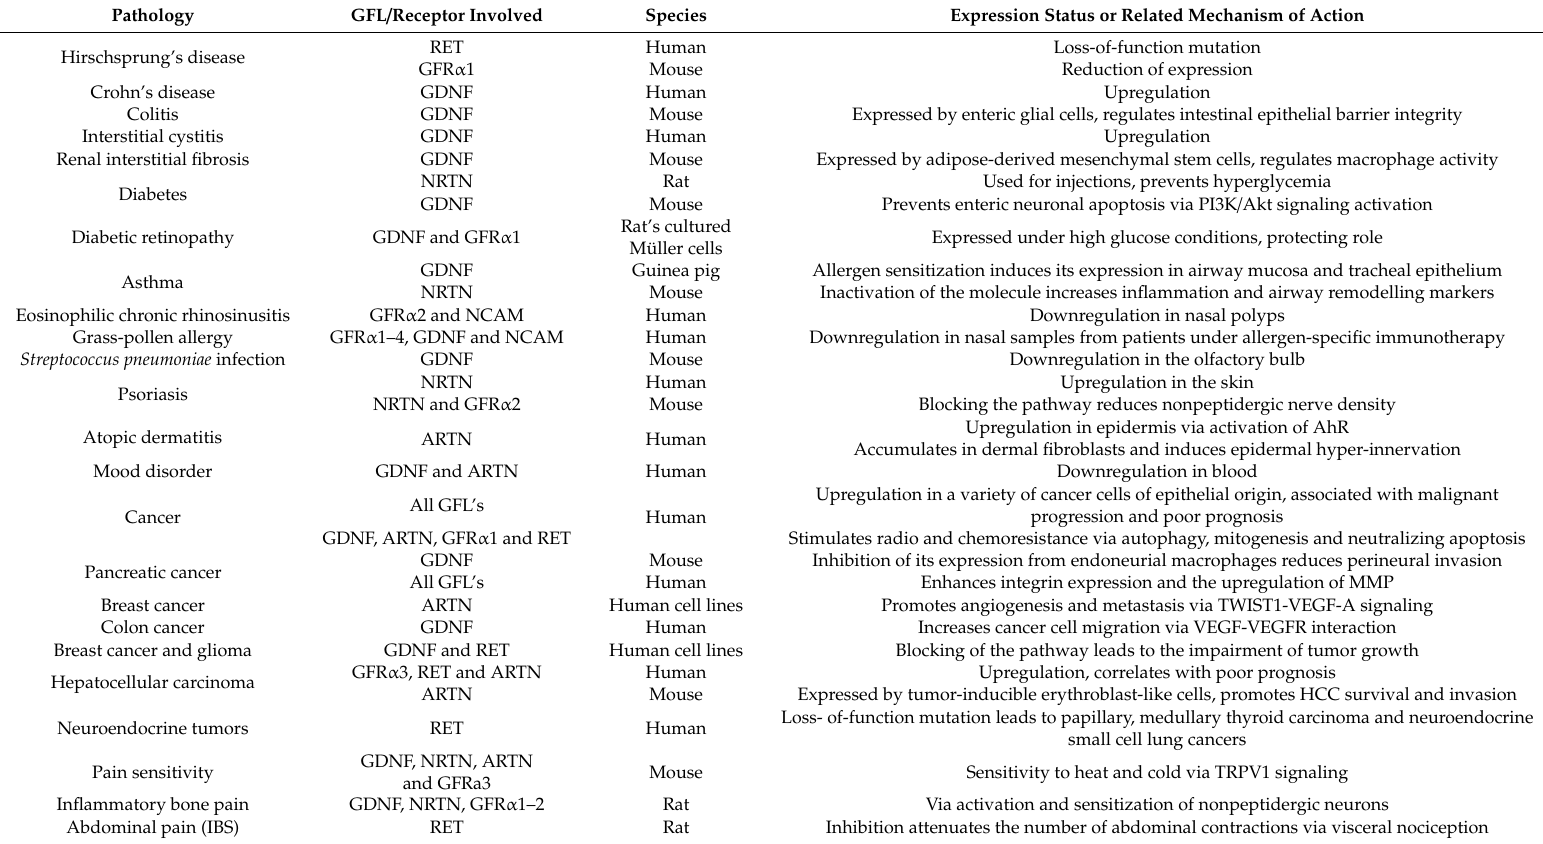
Table 1. Summary of the involvement of GFLs in di ff erent pathologies and models and their expression status or related mechanism of action. PI3K: phosphoinositide 3-kinase; Akt: protein kinase B; AhR: aryl hydrocarbon receptor; MMP: matrix metalloproteinase; TWIST1: twist-related protein 1; VEGFA: vascular endothelial growth factor A; VEGFR: vascular endothelial growth factor receptor; HCC: hepatocellular carcinoma; TRPV1: transient receptor potential cation channel subfamily V member 1; IBS: irritable bowel